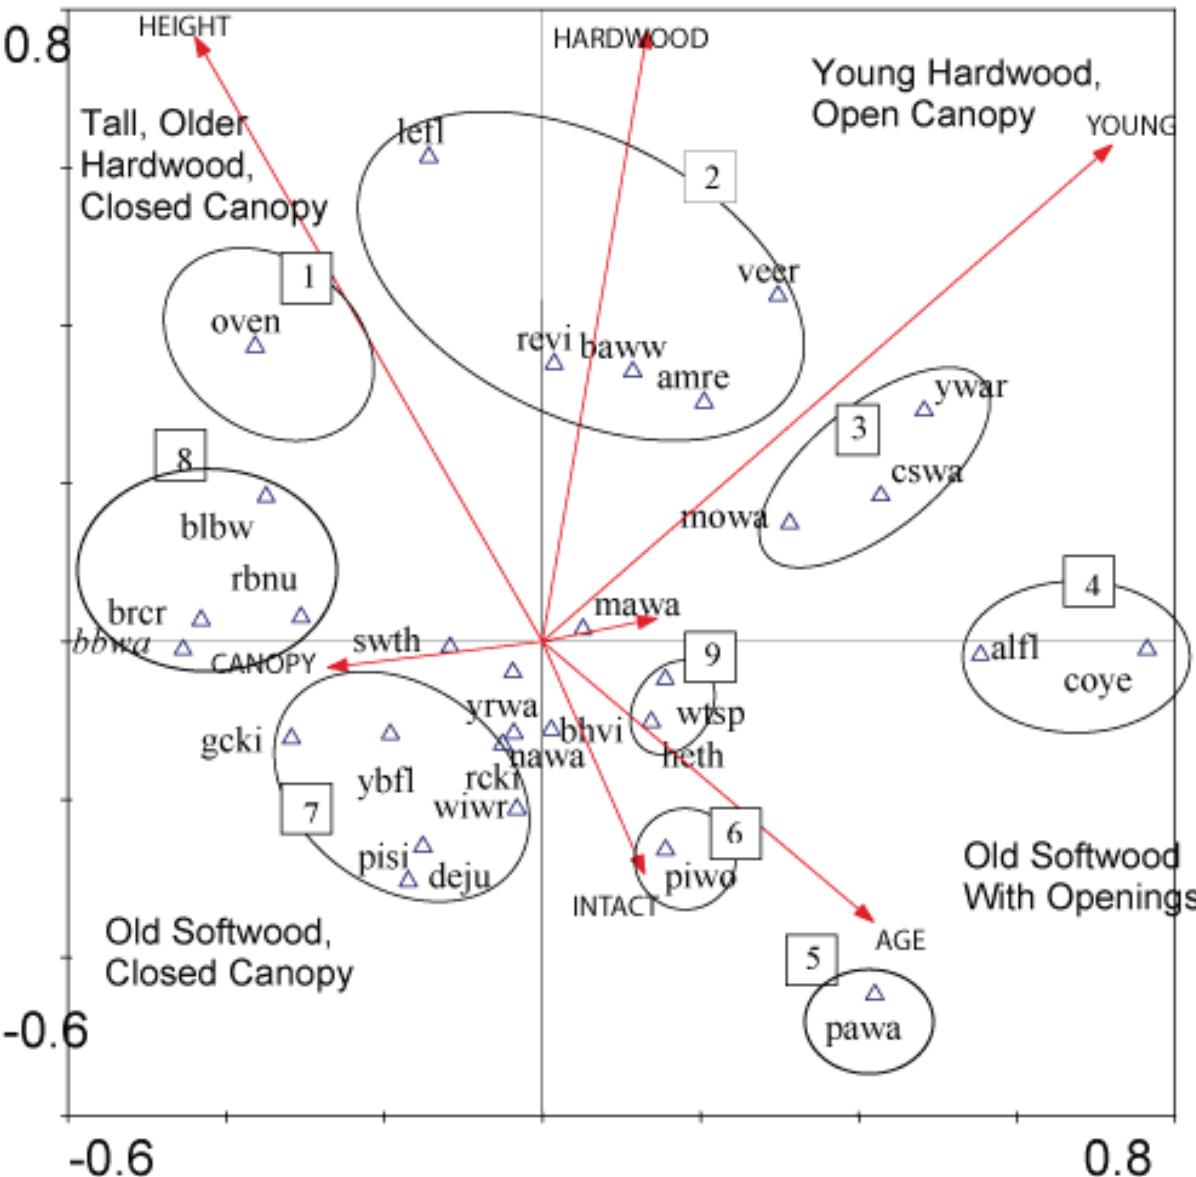
Fig. 7. Partial correlations (conditional effects) of standardized environmental variables with species occurrence, where conditional effects are represented by arrows pointing in the direction of positive associations, assuming the other environmental variables are held at their mean values. Length of the arrow represents the component of variance accounted for by that factor in predicting overall community